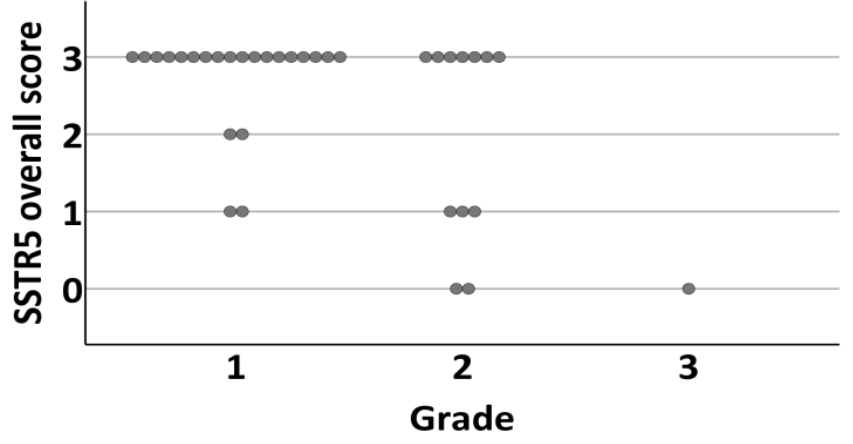
Figure 6. Distribution of tumors overall SSTR5 expression (0 = negative, 1 = weak expression, 2 = moderate expression, 3 = strong expression) according to grade (1–3) of the tumor. Grade 1 tumors were positive for SSTR5 in 91% ( n = 20) (Figure 7a–h) and grade 2–3 tumors in 54% ( n = 8). Interestingly, there was no association between SSTR1, SSTR2, SSTR3, or SSTR4 expression and Ki-67 PI or tumor grade ( p = 0.004).